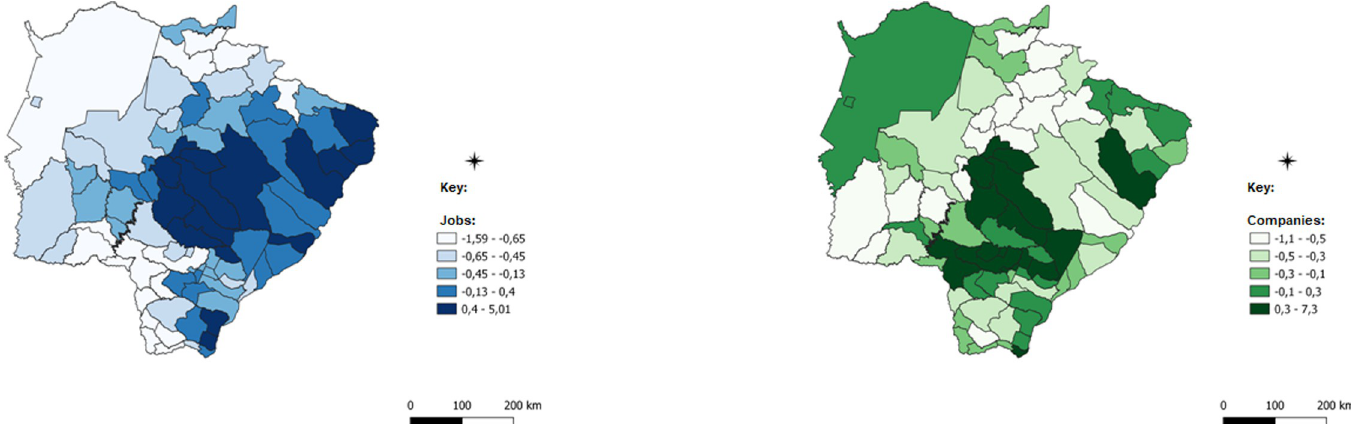
Fig 8. Spatially weighted Composite Trade Concentration Index. Caption credit: Elaborated from secondary data extracted from [26].